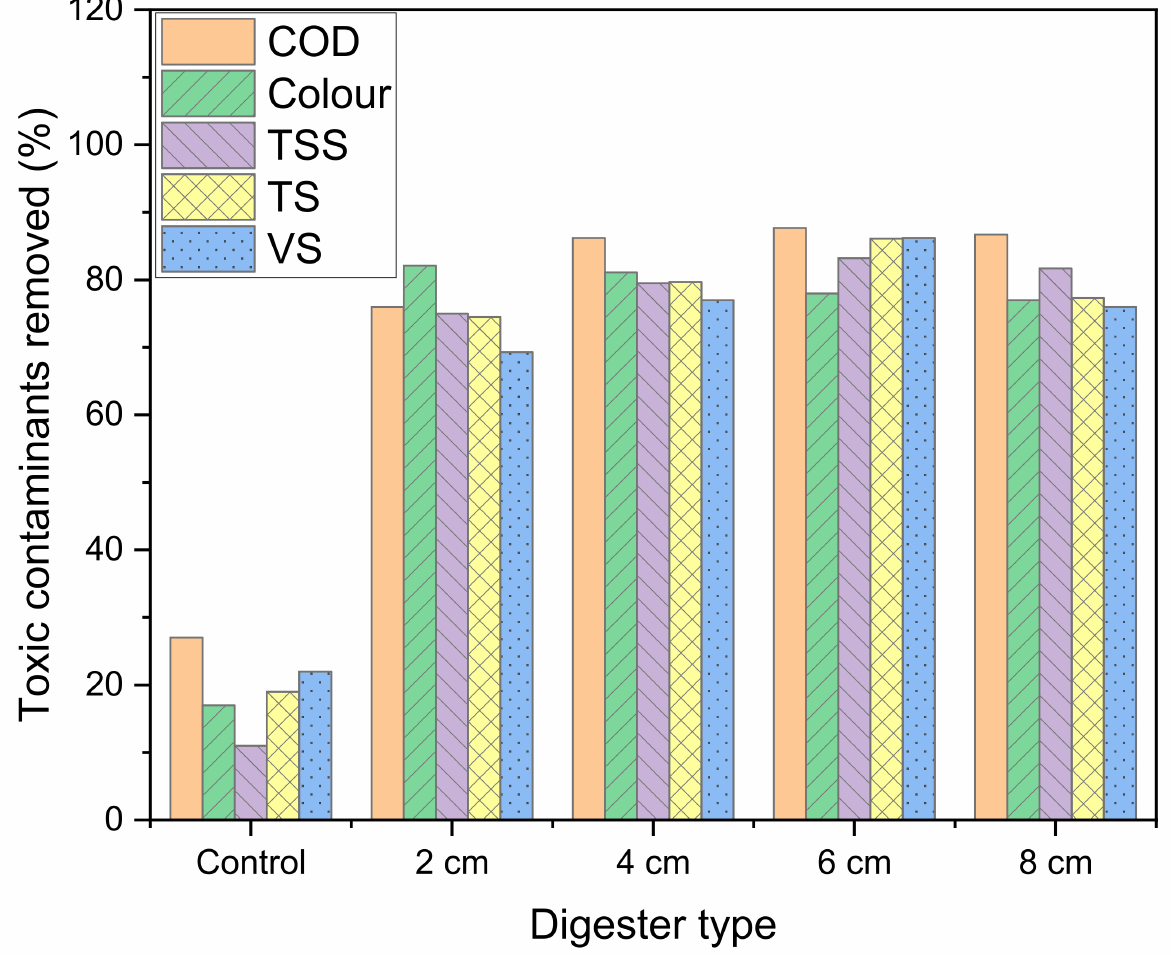
Figure 10. Influence of electrode spacing on toxic contaminants